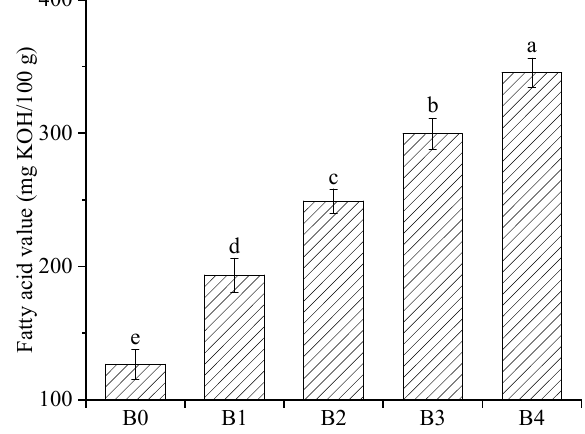
Figure 5. Fatty acid value of the wheat bran. The B0, B1, B2, B3, and B4 are the wheat bran prepared Figure 5. F atty acid value of the wheat bran . The B0, B1, B2, B3, and B4 are the wheat bran prepared under the rolling frequencies 0, 6, 9, 12, and 15 times. Different lowercase letters on the shoulders of under the rolling frequencies 0, 6, 9, 12, and 15 times . Different lowercase letters on the shoulders the column indicate significant differences ( p < of the column indicate significant differences ( p < 0.05).